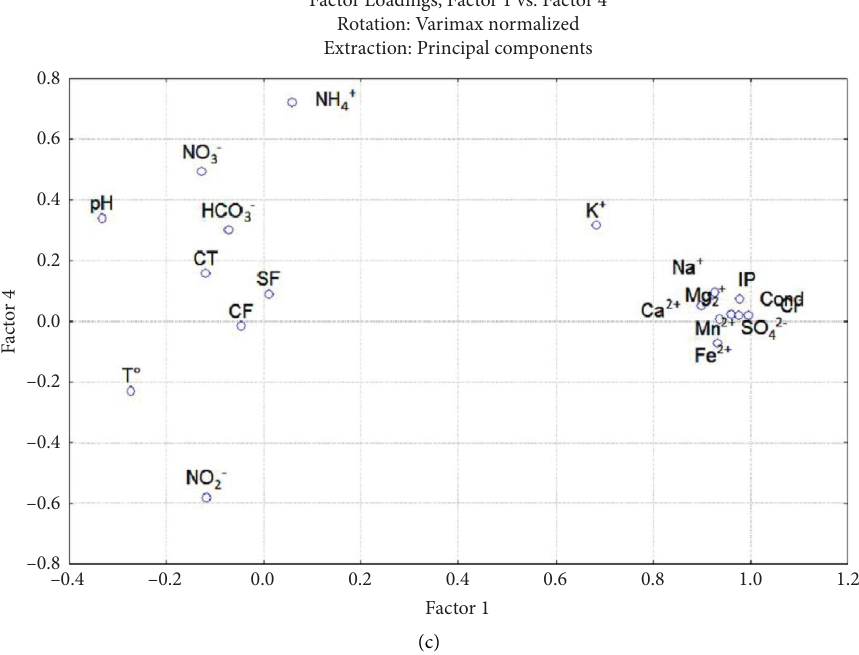
Figure 6: Te distribution of the nineteen physicochemical and bacteriological parameters on the factorial plane (Factor 1-Factor 2), (Factor 1–Factor 3), and (Factor 1–factor 4) by the varimax rotation in the Angads aquifer in